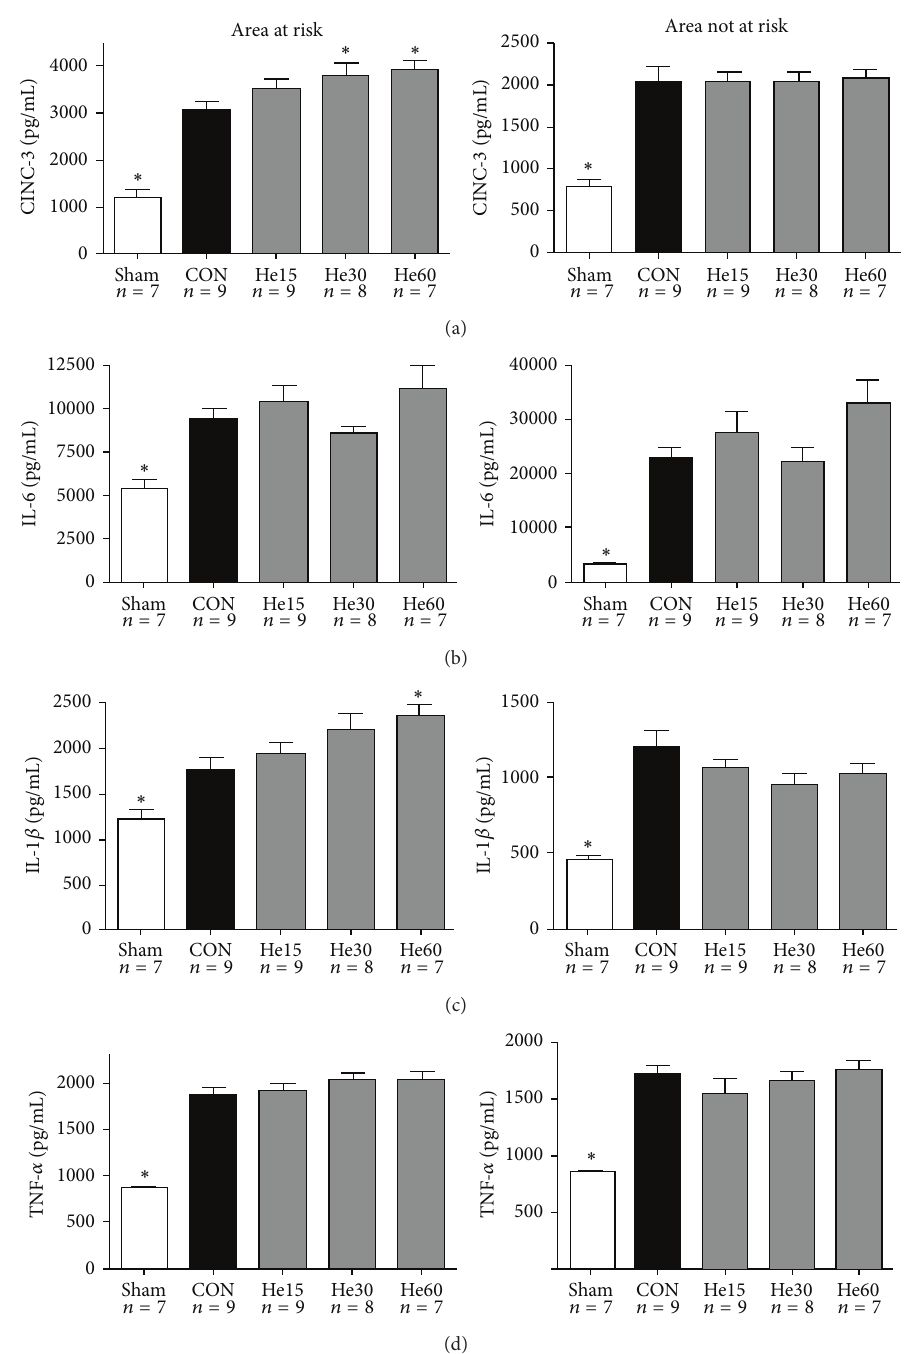
Figure 2: Protein levels of CINC-3 (a), IL-6 (b), IL-1 𝛽 (c), and TNF- 𝛼 (d). Protein levels are determined in myocardial tissue after completion of the experimental protocol: all animals underwent 15min of stabilization, 25 min of ischemia, and 120 min of reperfusion, except for Sham animals. Sham animals were not exposed to ischemia and reperfusion. Animals receiving helium postconditioning received 15, 30 or 60 min of helium. All data are shown as mean ± S.E.M. Amount of experiments in each group is shown below individual bars. Groups were tested with one-way ANOVA plus a Dunnet post hoc test comparing the control group against all other groups; ∗ 𝑃 < 0.05 , significant in comparison to